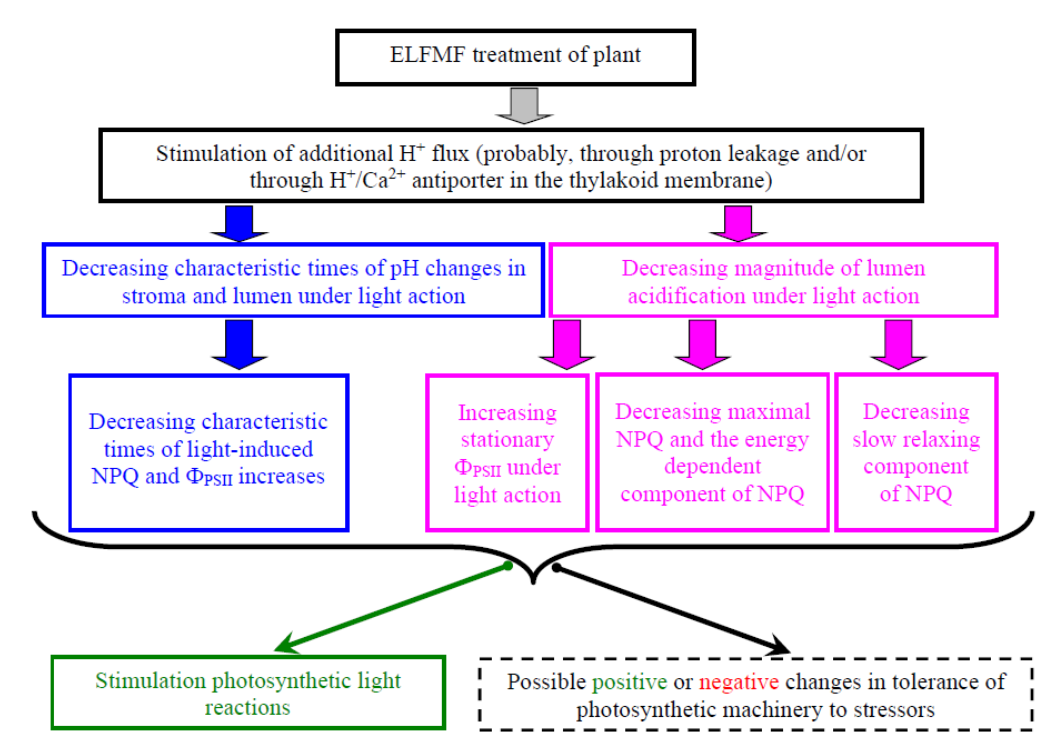
Figure 9. Scheme of potential ways of influence of the 14.3 Hz extremely low-frequency magnetic fields (ELFMF) on photosynthetic parameters of plants (see Section 3 for details). The dotted box shows the possible influence of ELFMF on photosynthetic tolerance to actions of stressors; however, this influence requires further